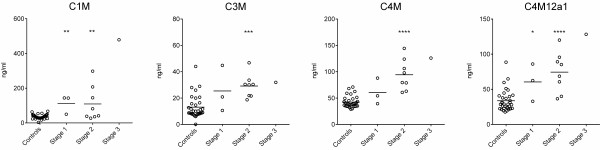
Levels of MMP-generated fragments of type I (C1M), type III (C3M) and type IV (C4M and C4M12a1) collagen from PC patients as divided by tumor stage. Biomarkers of MMP-2/-9/-13 mediated degradation of type I collagen (C1M), MMP-9 mediated type III collagen (C3M) and MMP-9 mediated (C4M) and MMP-12 mediated (C4M12a1) degradation of type IV collagen in serum from the patients (three of the patients had unreported stage) with pancreatic ductal adenocarcinomas (PDAC) and healthy controls. Stage 1 and 2 were compared to controls by ANOVA on Log transformed data. Significance levels: *p < 0.05, **p < 0.01, ***p < 0.01, ****p < 0.0001.